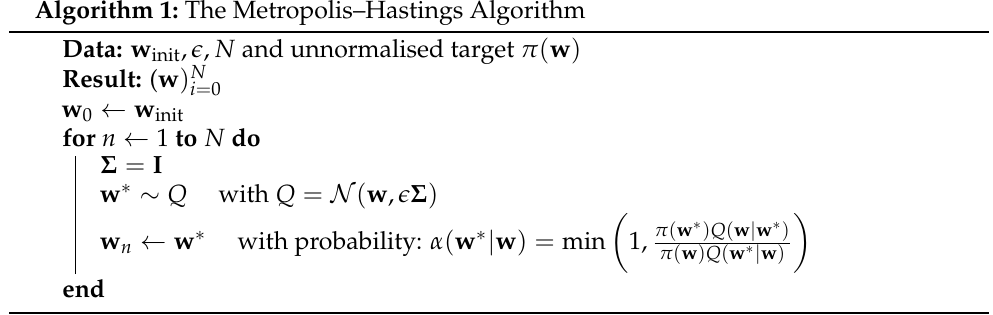
Algorithm 1: The Metropolis–Hastings